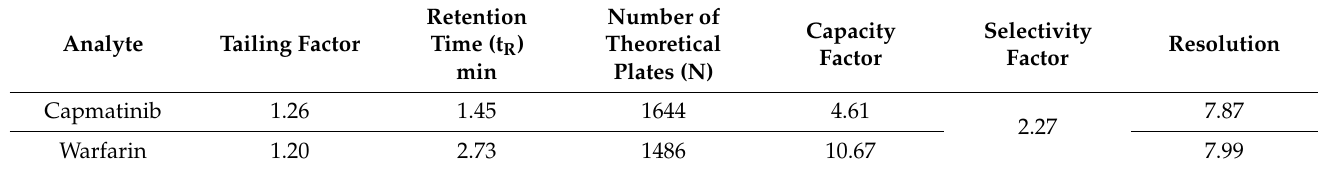
Table 1. Chromatographic parameters of the proposed HPLC-FLD